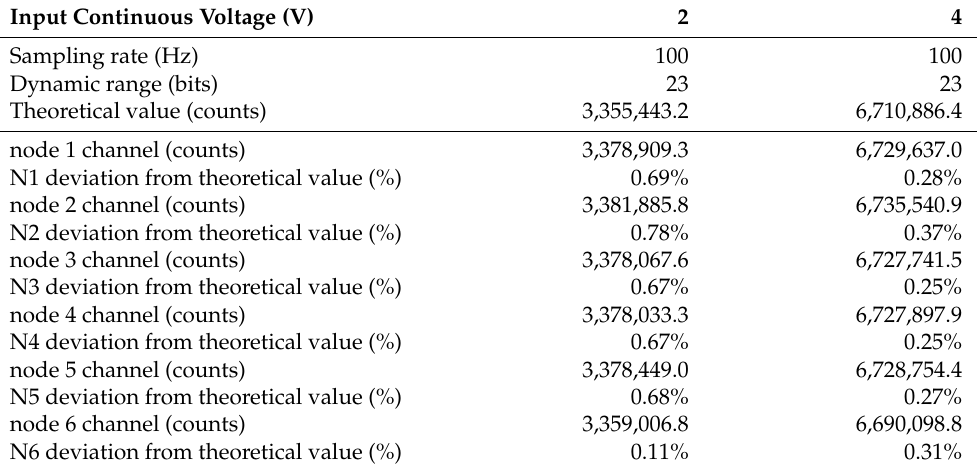
Table 2. Experimental sensitivity results for the six